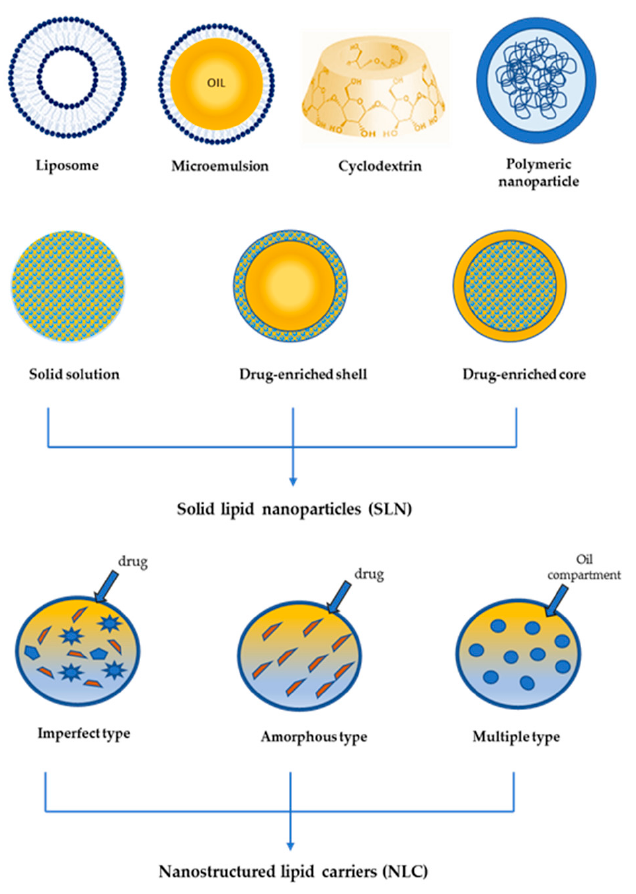
Figure 3. Schematic representation of drug delivery systems.